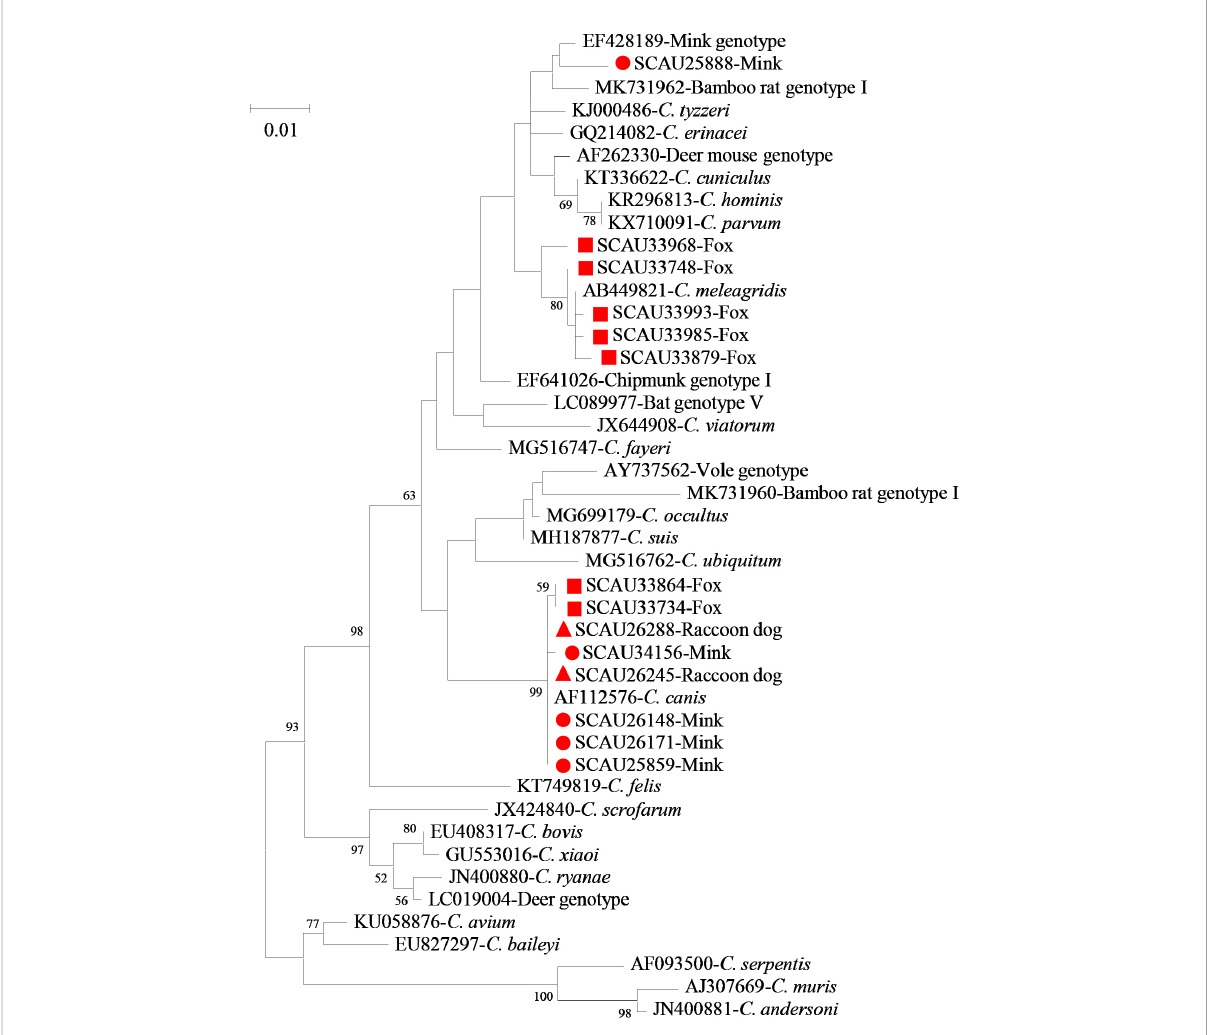
FIGURE 1 Phylogeny of Cryptosporidium spp. based on the maximum likelihood analysis of the partial SSU rRNA gene using the general time-reversible model for the calculations of substitution rates. Bootstrap values greater than 50% from 1,000 replicates are displayed. Samples detected in minks, raccoon dogs and foxes from this study are indicated with red circles, triangles, and squares,